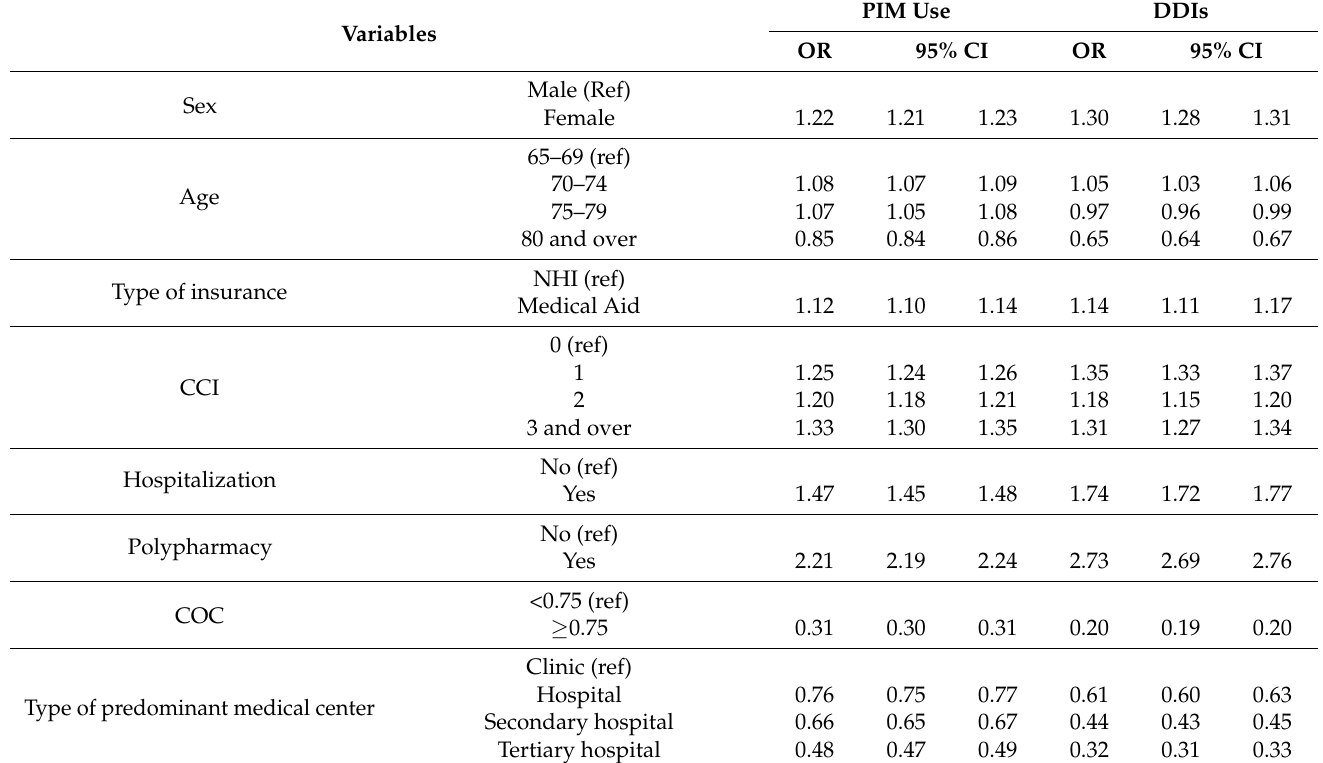
Table 4. Predictors of PIM use and drug–drug interactions among older